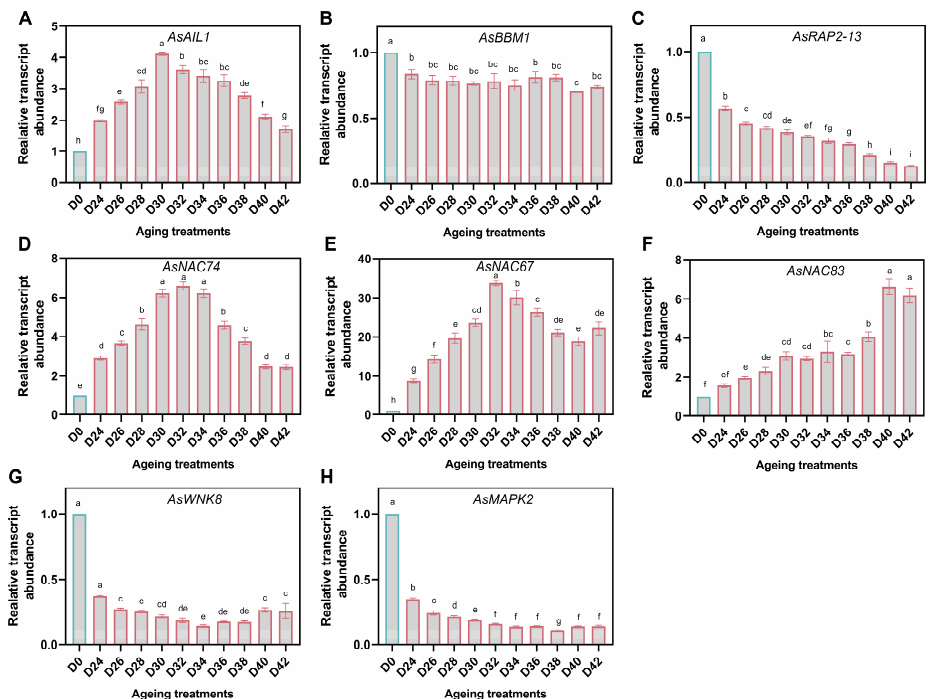
Figure 8. Relative expression levels of AP2 transcription factor family members ( A – C ), NAC tran- scription factor family members ( D – F ) and MAPK cascades members ( G , H ) in oat seeds. The letters represent statistical significance among the treatments, and the vertical bars represent the ± SEM at p < 0.05 level for three replicates. The mean values sharing the same letters, obtained from Duncan test, are not significantly different.